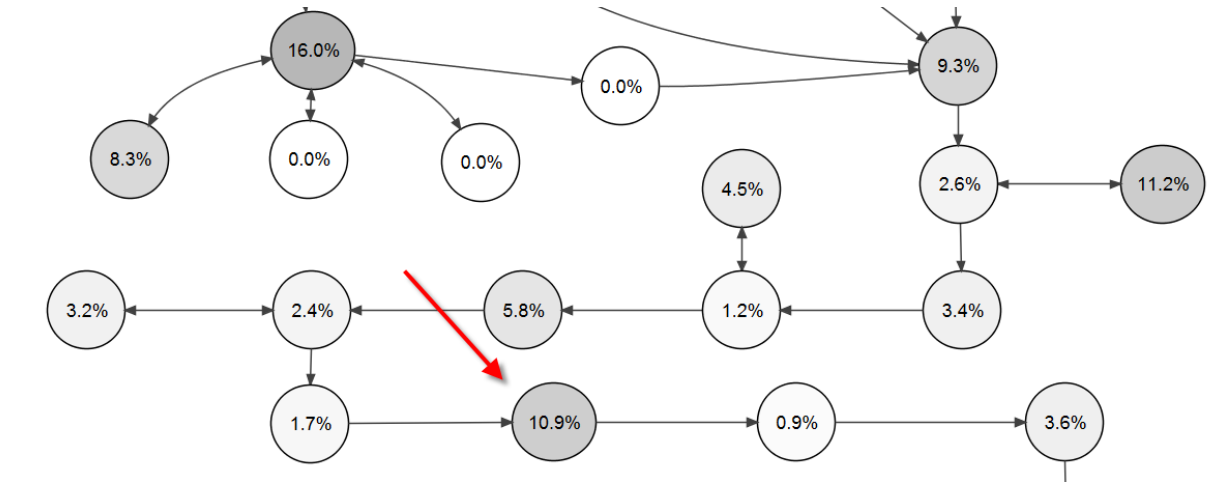
Figure 8. Visualization of learner choices in decision